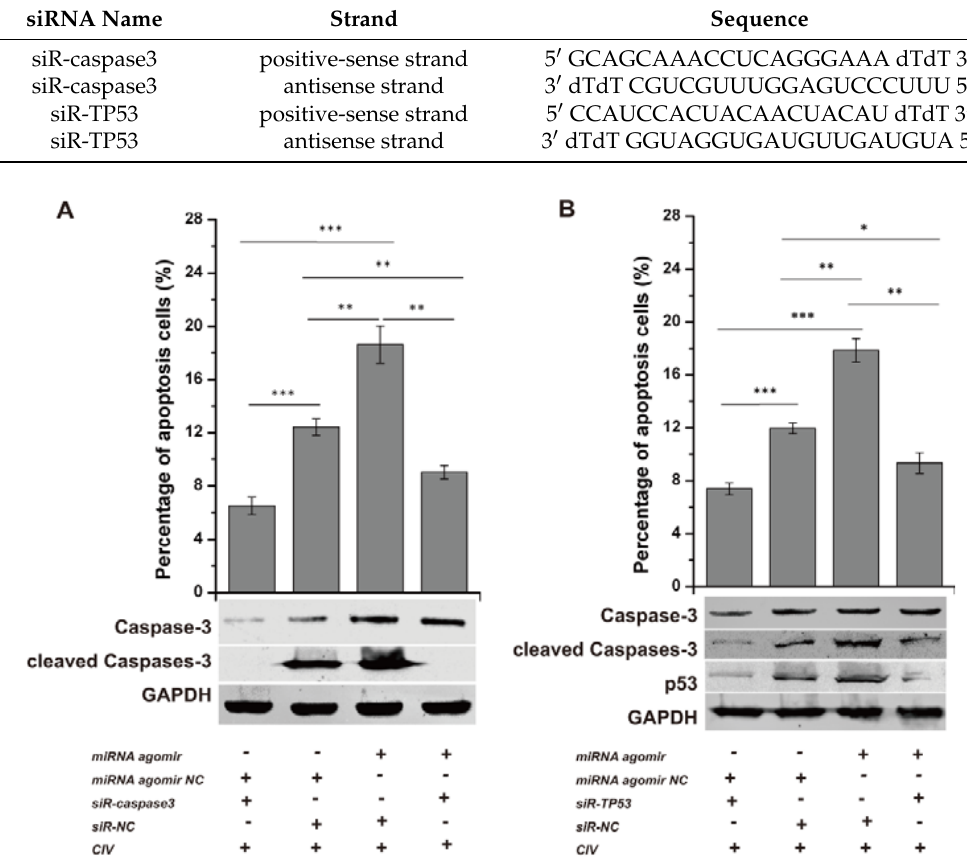
Figure 5. Interference assay. siRNAs were transfected into Madin-Darby Canine Kidney (MDCK) cells for 36 h and subsequently infected by CIV H3N2 (Multiplicity Of Infection, MOI = 1.0) at 12 h. The cells were collected to detect apoptosis. To explore the function of the p53 pathway in CIV-infected MDCK cells, siRNAs targeting TP53 (siR-TP53) and caspase3 (siR-caspase3) were applied individually or jointly with agomir and antagomir. siR-caspase3 restricted the expression and activation of caspase3 as shown by Western blotting and decreased the apoptosis induced by the cfa-miR-143 agomir as shown by flow cytometry ( A ); siR-TP53 restricted the expression and activation of p53 and the activation of caspase3 as shown by Western blotting and decreased apoptosis induced by cfa-miR-143 agomir as shown by flow cytometry ( B ). Differences in expression levels were considered significant if p < 0.05 (* p < 0.05; ** p < 0.01; *** p < 0.001).